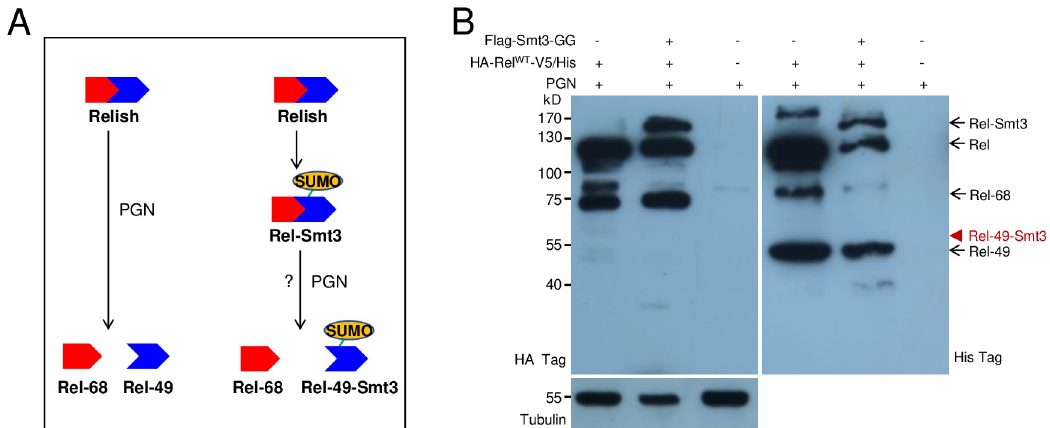
Fig 7. SUMOylated Relish may be inhibited for cleavage. (A) A prediction to show the cleavage of Rel-Smt3 to produce a fragment of Rel-49-Smt3. Wild type Relish can be cleaved into Rel-68 (nuclear translocation) and Rel-49 (in cytoplasm). Upon SUMOylation, Smt3 is mainly covalently coupled to K823 near the C-terminus. Thus, if Rel-Smt3 could also be cleaved like Rel WT , it should produce two fragments, Rel-68 and Rel-49-Smt3. Due to the coupled Smt3, the molecular weight of Rel-49-Smt3 should be larger than Rel-49. (B) Undetectable Rel-49-Smt3 on Western blot. By increasing the amount of plasmid containing Smt3-GG and extending the time to collect S2 cells, we increased the amount of Rel-Smt3. Upon PGN addition (PGN alone: PGN + S2 cells), Rel-68 and Rel-49 were all detectable. The proposed band position of Rel-49-Smt3 as indicated by the red arrowhead did not exist. This experiment was repeated three times with similar results.